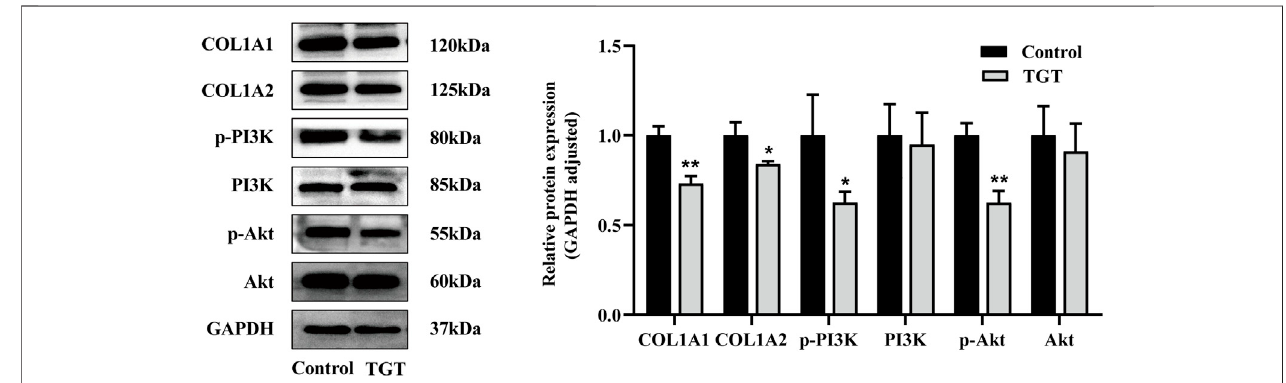
FIGURE 9 | Western blotting of differentially expressed proteins, including the protein bands and relative abundance. All values represent the means ± SD ( n = 3, compared with the control group: p p < 0.05 pp p < 0.01).